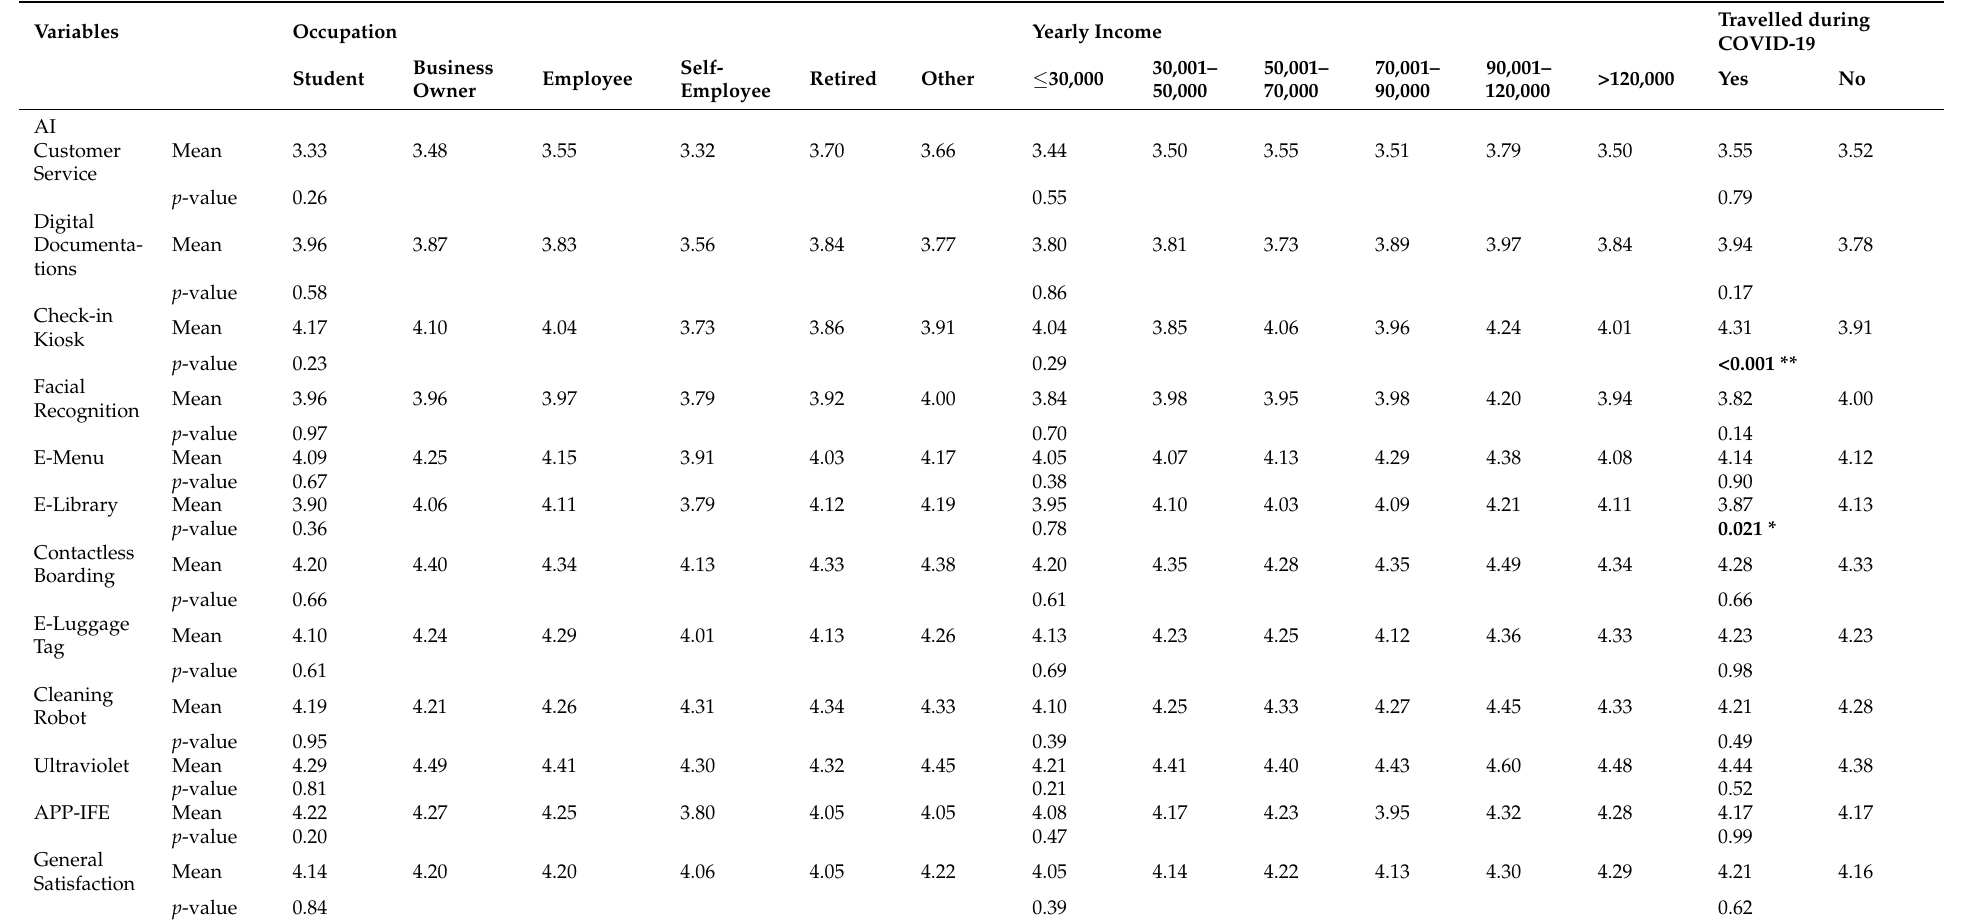
Table A2. ANOVA results for 12 variables show the relationship between occupation, yearly income and travel during